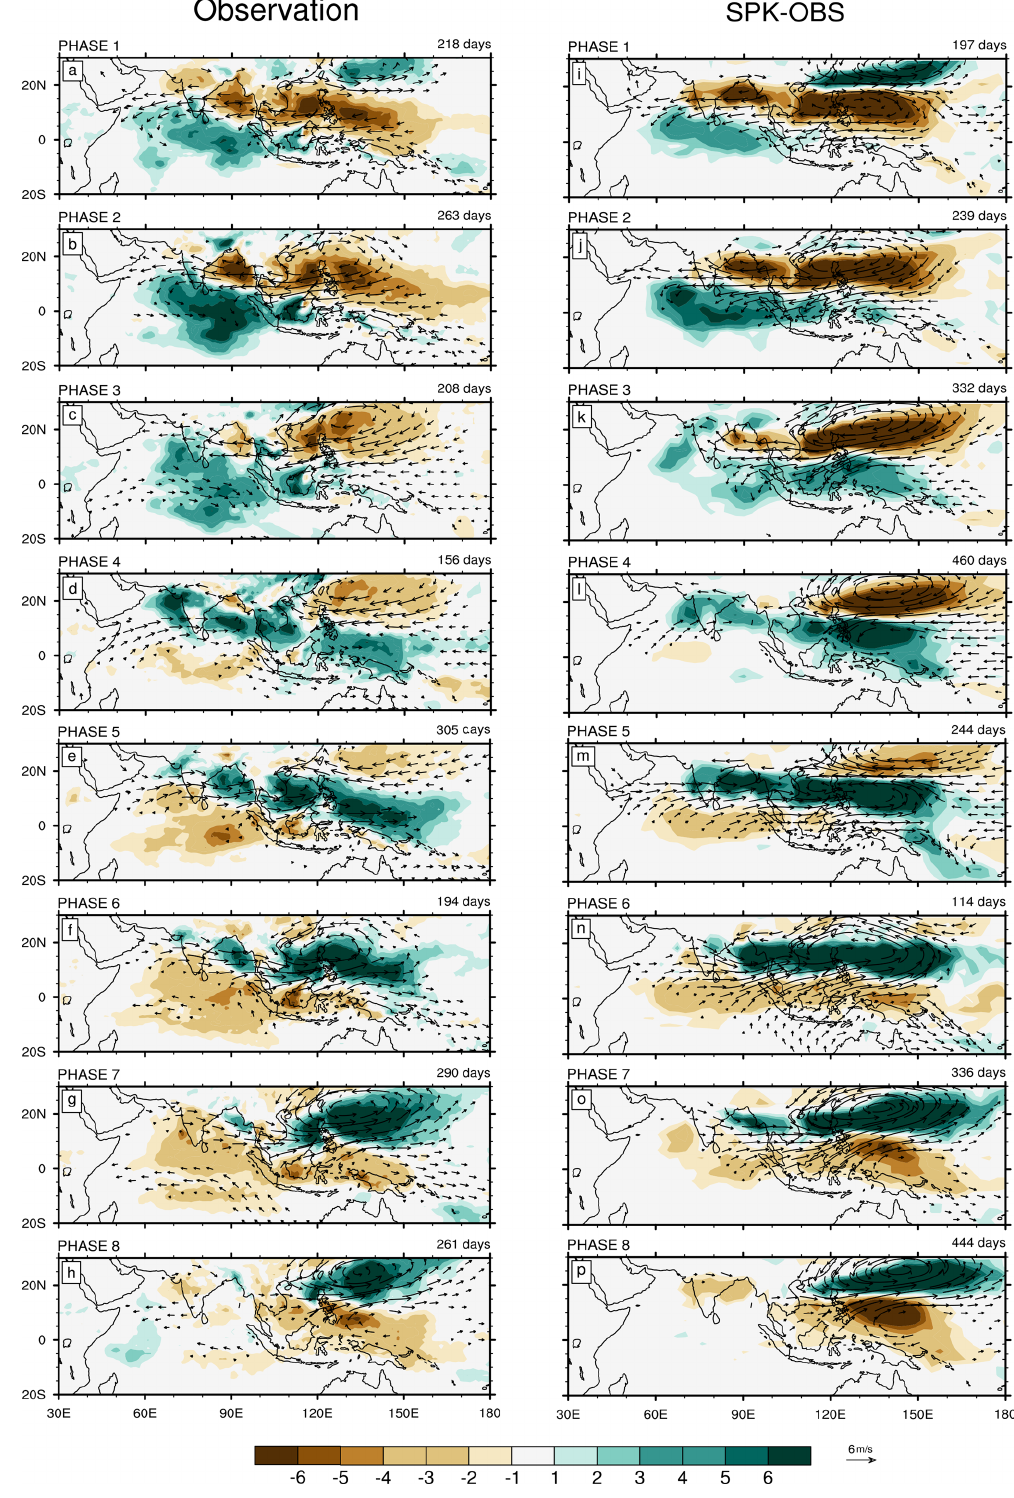
Figure 10. Composites of anomalous precipitation (shading; mmd − 1 ) and 850hPa wind (vector; with amplitude > 1ms − 1 ) in the BSISO life cycle from phase 1 to phase 8 for (a–h) GPCP precipitation and ERAI 850hPa wind and (i–p) SPK-OBS. The number of days for the phase composite is shown at the right corner above each panel. Only strong BSISO events (amplitude ≥ 1.5) are selected.